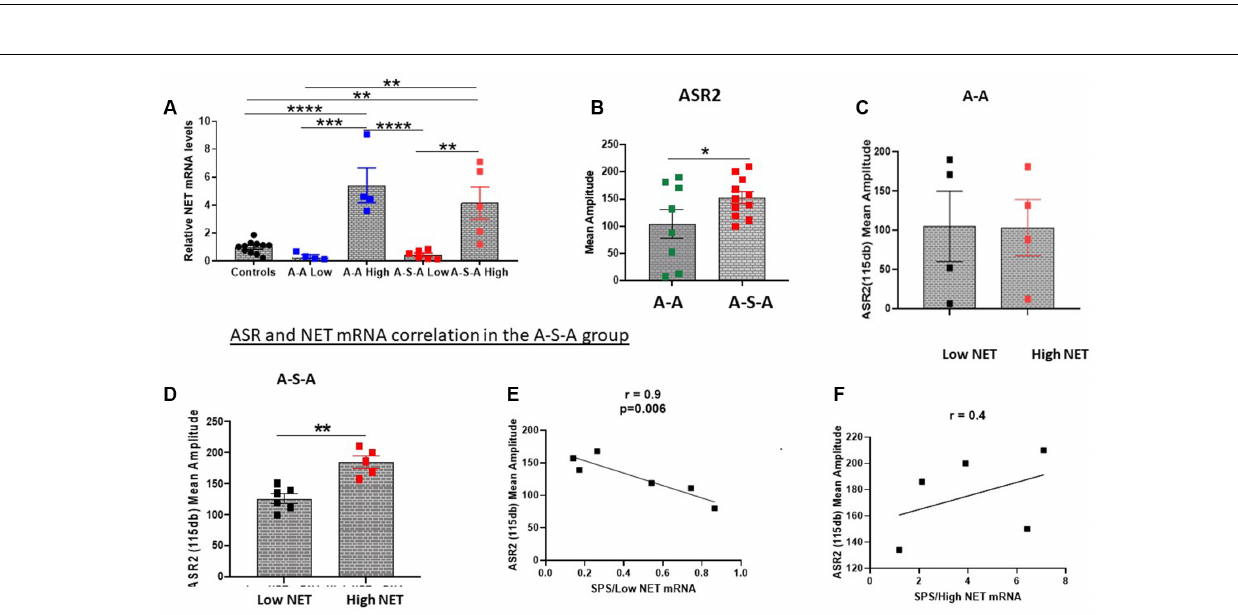
FIGURE 2 | Relationship between changes in ASR and NET gene expression in the LC. NET mRNA expression was determined in groups tested for ASR before and 2 weeks after SPS (A-S-A), or without SPS (A-A) or unstressed controls (Experiment 3). The groups were divided based on two standard deviations from the mean of the controls (A) . ASR2 was higher in the A-S-A group compared to the A-A group (B) . The associated ASR response of each individual animal to NET mRNA expression is shown for the A-A group (C) and A-S-A group (D) . The correlation between ASR2 and NET mRNA in the Low NET (E) and high NET (F) A-S-A subgroup are shown. Each dot represents an individual animal, * p < 0.05, ** p < 0.01, *** p < 0.001, **** p < 0.0001. ASR, Acoustic Startle Response.